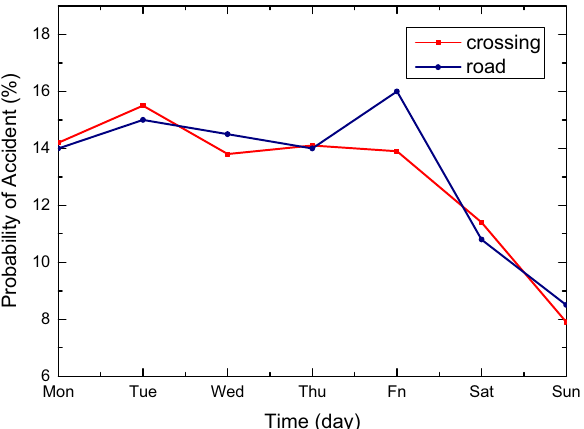
Figure 2. The accident incidence rate in weeks of crossing and road in shanghai are fitted by linear relationship. It can be seen from the figure that the overall trend is downward.